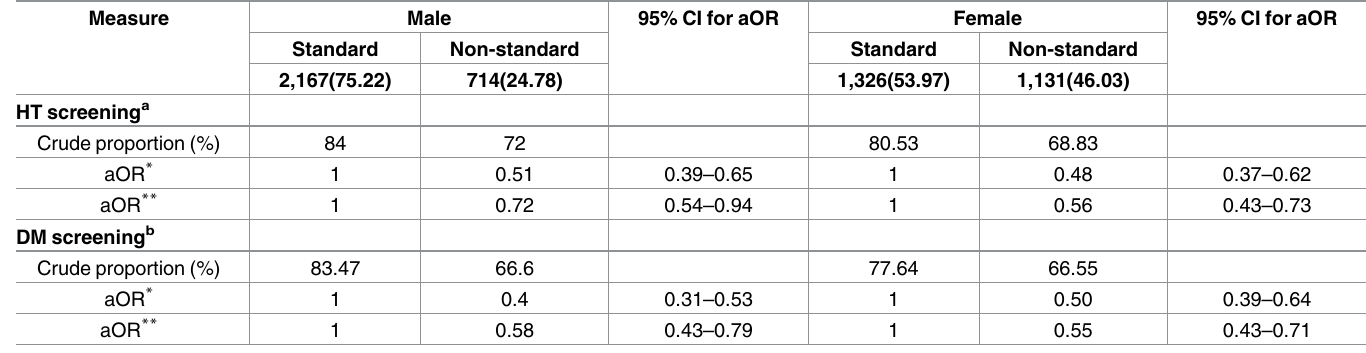
Table 4. Differencesin the use of cardiovascular health screening servicesbetween standard and non-standard